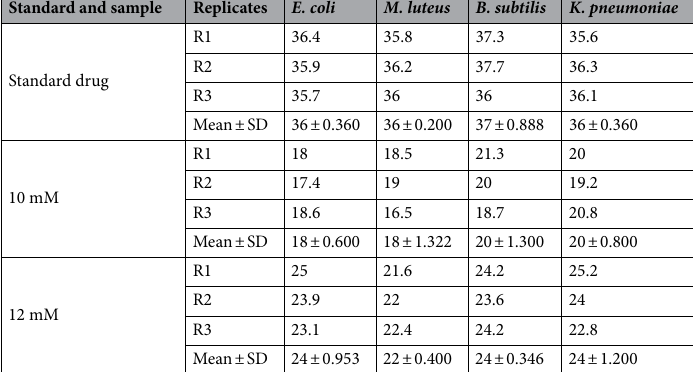
Standard and sample Replicates E. coli